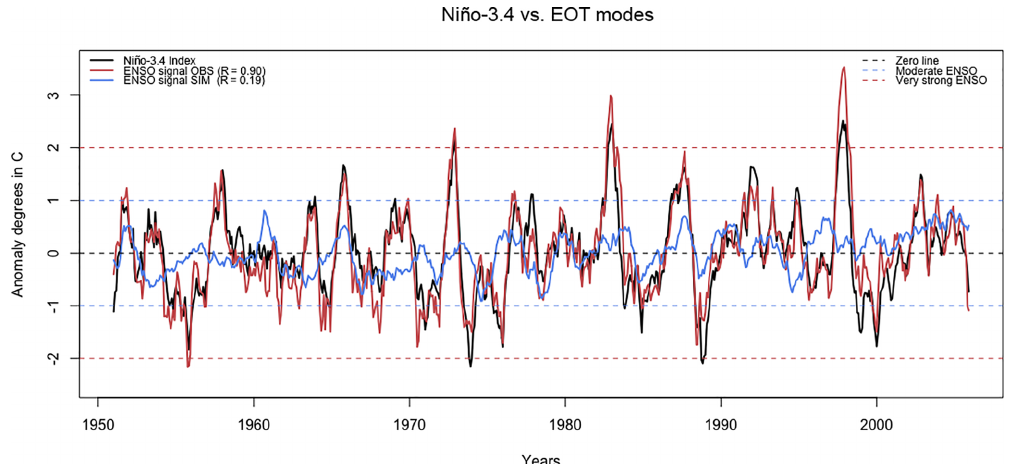
Figure 1. The comparison between the Niño-3.4 Index recorded by NOAA (black line), time series of the first mode obtained from the EOT analysis of observed CRU-NOAA datasets (red), and time series of the first mode obtained from the EOT analysis of ensembles of the climate model simulations (blue). Black dashed line: zero line. Blue dashed lines ± 1 . 0 ◦ anomaly thresholds for categorizing moderate ENSO events. Red dashed lines: ± 2 . 0 ◦ anomaly thresholds for categorizing very strong ENSO